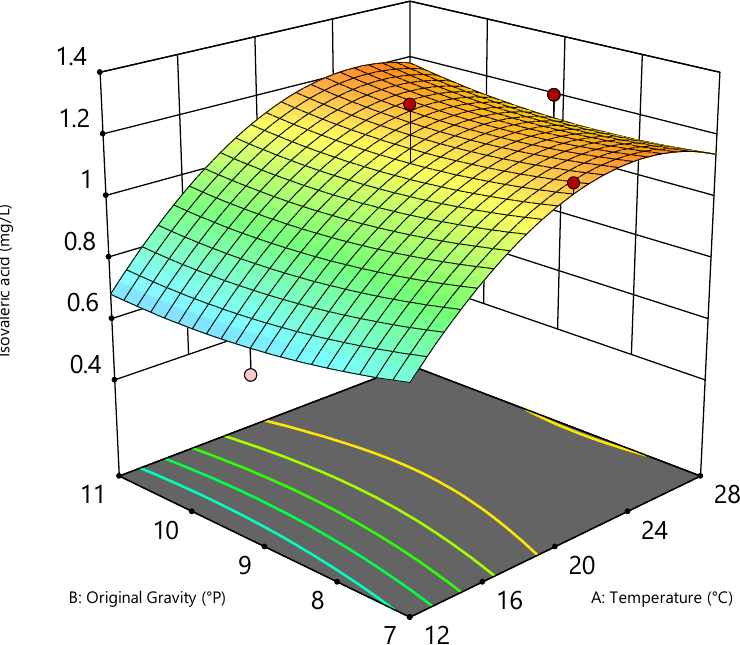
Figure 2. Three-dimensional (3D) diagram of the quadratic correlation of original gravity ( ◦ P), temperature ( ◦ C), and isovaleric acid concentration (mg/L) of the beers at a pitching rate of 15 × 10 6